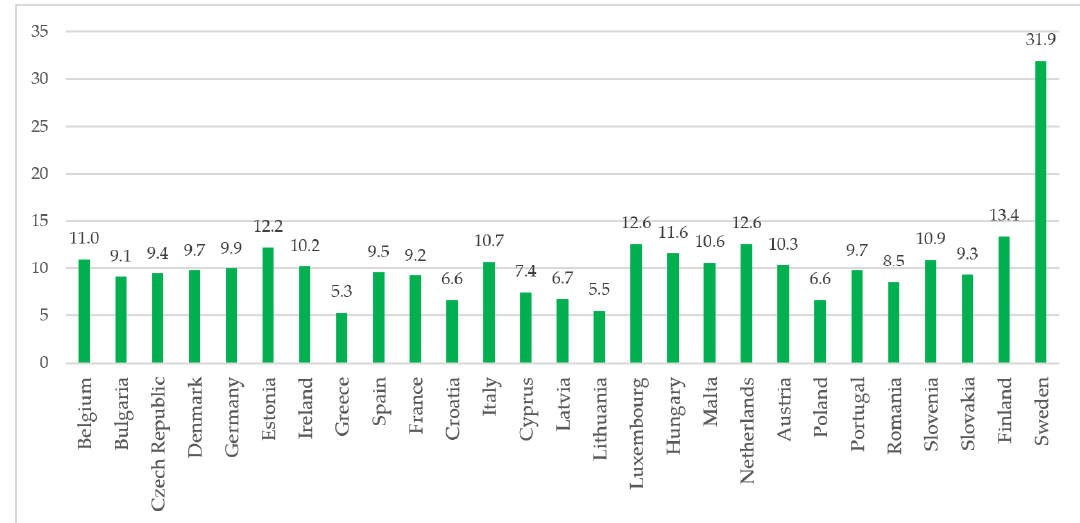
Figure 10. The share of RES in transport in EU countries in 2020, %. Source: [74].